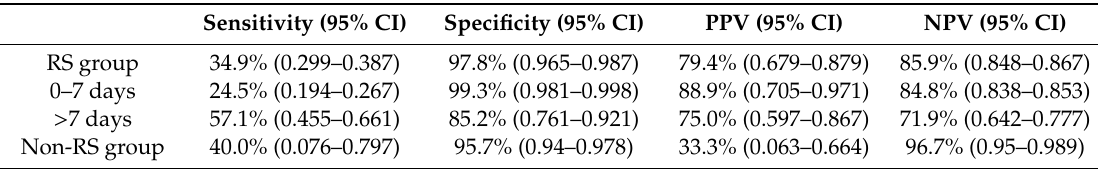
Table 4. Diagnostic performance of the rapid serological test versus the real-time PCR reference standard in the RS and Non-RS